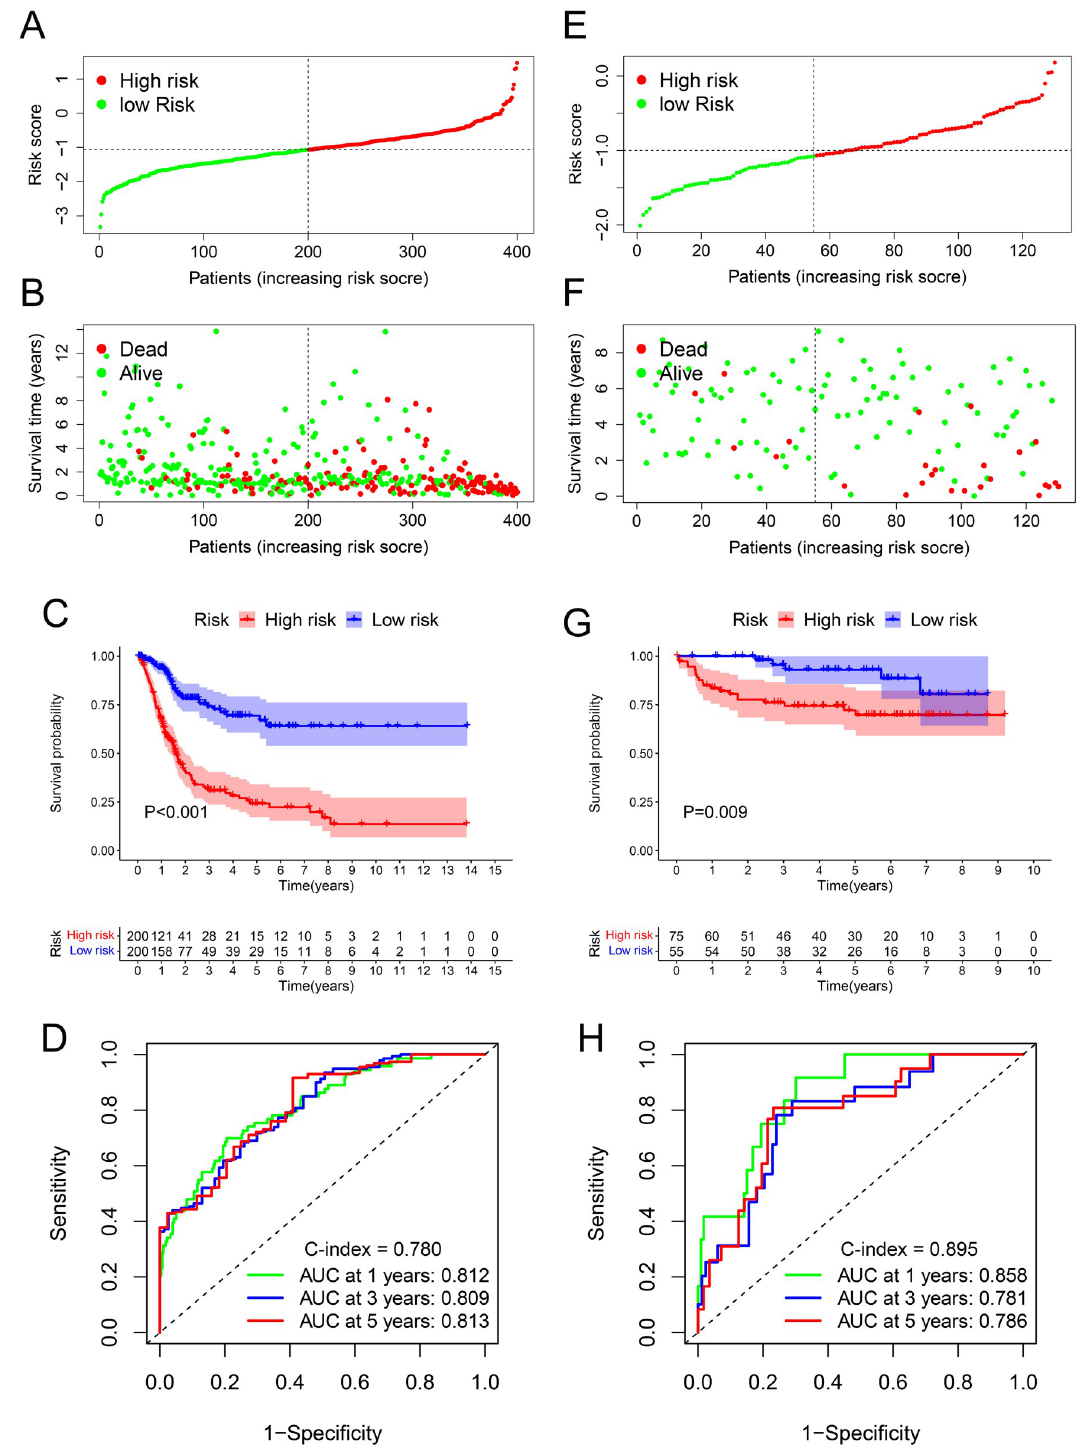
Fig 2. Establishment of the risk score. In the TCGA cohort, BC patients were distributed into different risk groups (A). Survival status of BC patients in different risk groups (B). The survival rate of the high-risk BC patients was worse than that of the low-risk patients (C). AUCs of the ROC curves were shown (D). In the verification cohort of the GEO, BC patients were distributed into different risk groups (E). Survival status of BC patients in different risk groups (F). The survival rate of the high-risk BC patients was worse than that of the low-risk patients (G). AUCs of the ROC curves were shown (H) TCGA, the Cancer Genome Atlas; GEO, Gene